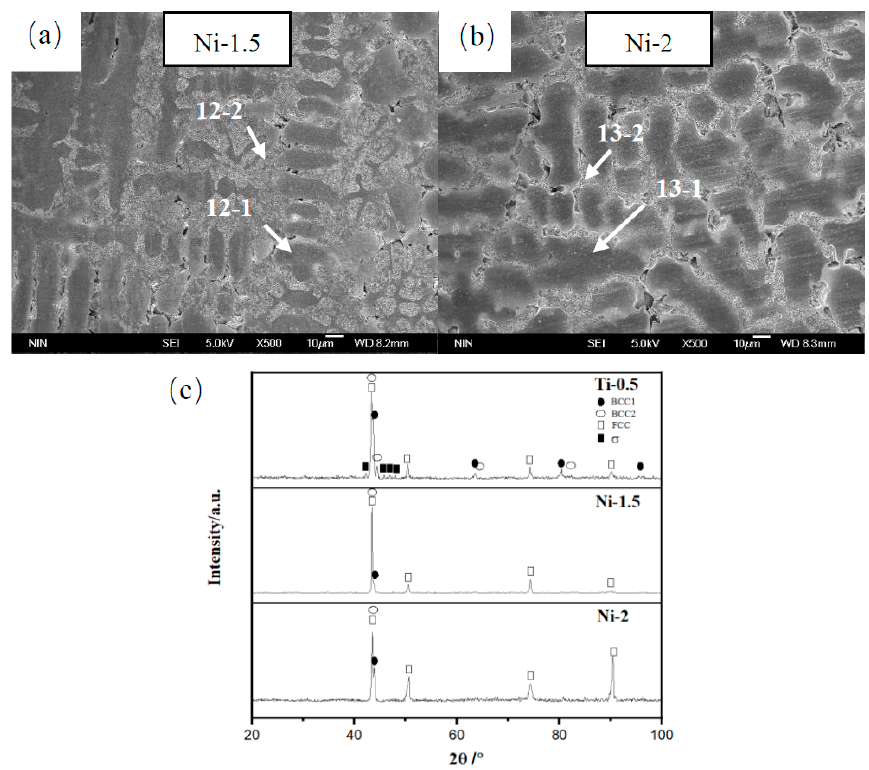
Figure 7. Microstructure and XRD results for Al0.5CoCrFeNi x Ti0.5 HEAs: ( a ) Ni-1.5 alloy, ( b ) Ni-2 alloy; and ( c ) XRD results. alloy; and ( c ) XRD results. Table 8. EDS results for Al0.5CoCrFeNi x Ti0.5 HEAs. Table 8. EDS results for Al0.5CoCrFeNi x Ti0.5